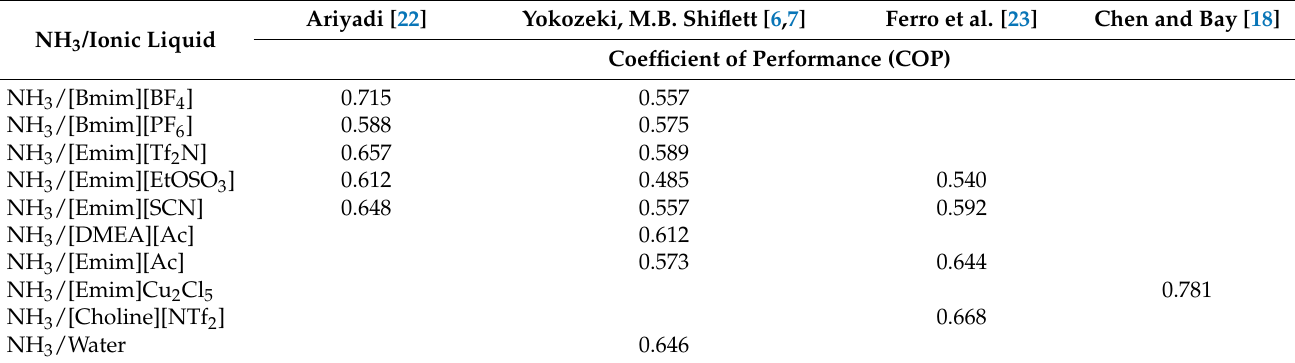
Table 1. The coefficients of performance of absorption refrigeration systems using various NH 3 /Ionic liquids. NH 3 /Ionic